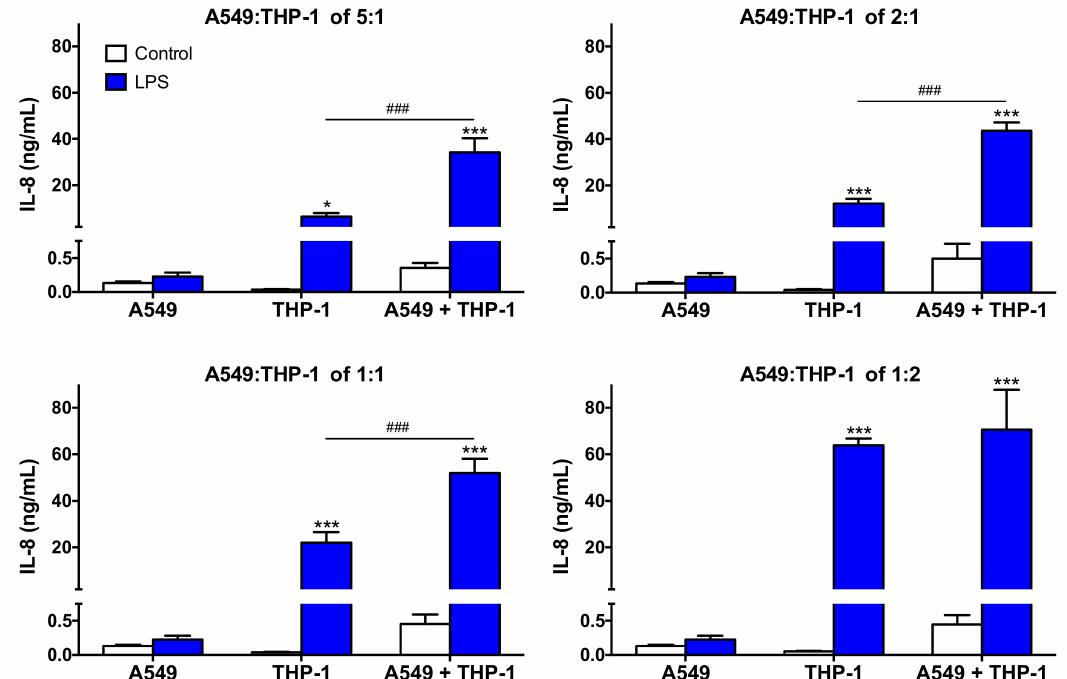
Figure 3. Capacity of the co-culture models to respond to a pro-inflammatory stimulus. Mono- and co-cultures were exposed to 0.01 µ g/mL of LPS for 24 h, and the secretion of the pro-inflammatory cytokine IL-8 was measured in the culture supernatants. Data are means ± SEM of n = 3 experiments. Statistical differences at p < 0.05 (one symbol) and p < 0.001 (three symbols) were determined by ANOVA followed by the Tukey’s test when compared to control unexposed cells (asterisks) or to LPS exposed-THP-1 mono-culture